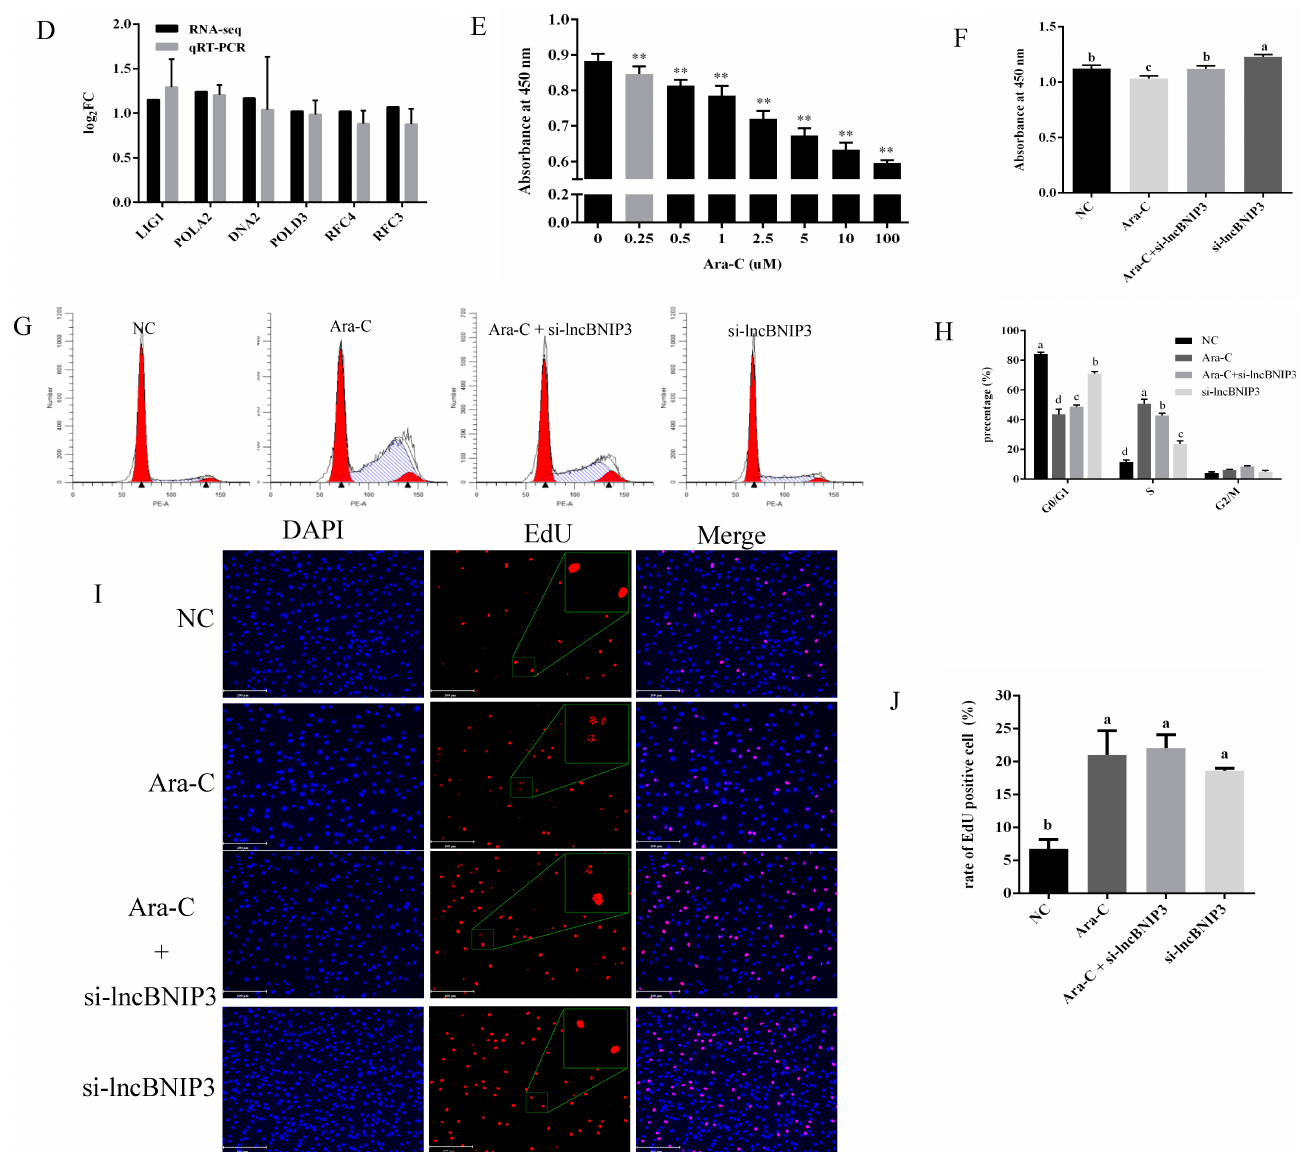
Figure 5. Interference with lncBNIP3 promoted the cell cycle and rescued the defective cell cycle caused by Ara-C. ( A ) KEGG pathway for cell cycle (bta04110) with the annotated DEGs. ( B ) Se- quencing data approved by RT-qPCR. ( C ) KEGG pathway for DNA replication (bta03030) with the annotated DEGs. ( D ) Sequencing data approved by RT-qPCR. ( E ) The CCK8 results of cells treated with Ara-C at different concentrations. ( F ) The CCK8 results of NC, Ara-C, Ara-C + si-lncBNIP3, and si-lncBNIP3 groups. ( G ) Cell flow cytometry results of NC, Ara-C, Ara-C + si-lncBNIP3, and si-lncBNIP3 groups ( H ) Statistical data of the flow cytometry results. ( I ) The EdU staining results of NC, Ara-C, Ara-C + si-lncBNIP3, and si-lncBNIP3 groups, scale bar: 200 µ m. ( J ) Statistical data of EdU-positive cell rate. Herein, Data are expressed as means ± SD. ** indicated extremely significant difference ( p < 0.01). And different lower cases (a–d) among different columns represent p <